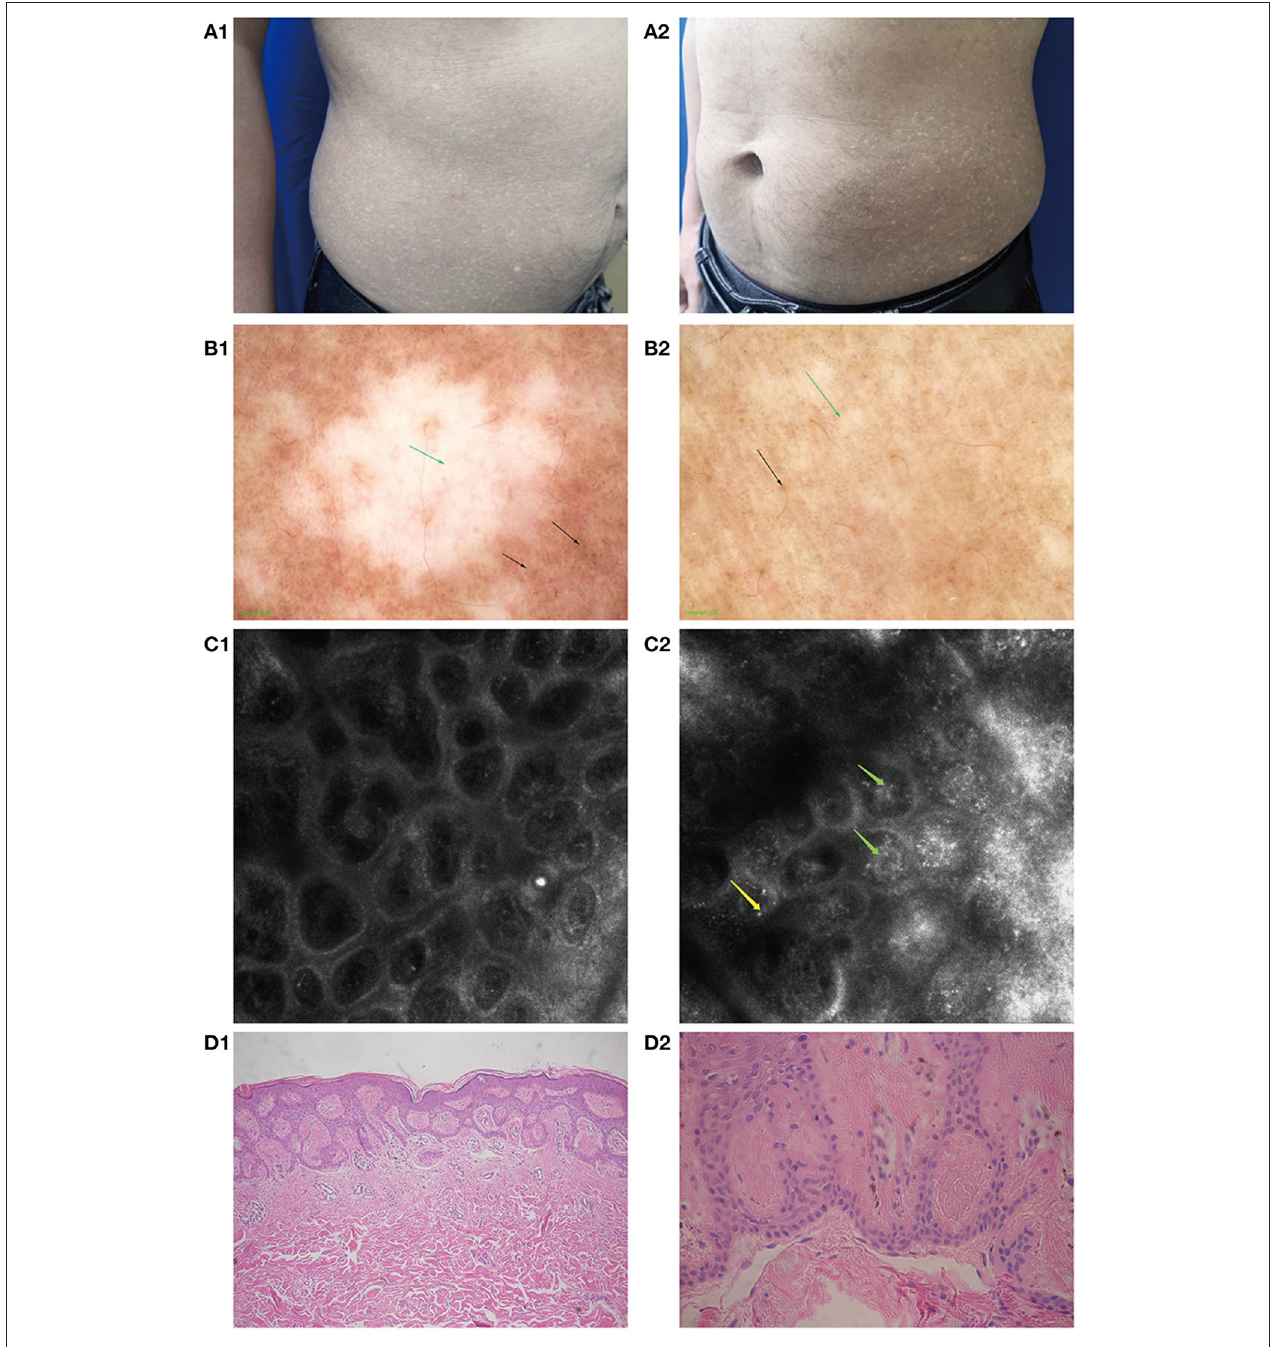
FIGURE 1 | Clinical manifestations, imaging changes, and pathological changes in amyloidosis cutis dyschromica (ACD). (A1,A2) Hyperpigmented and hypopigmented macules on the abdomen of a patient with ACD. (B1,B2) Feature of ACD under dermoscopy. (B1) Hypopigmented areas: white patch (green arrow) with blurred margins, white and brown blotches (black arrow) surrounded. (B2) Hyperpigmented areas: large fulvous pigmentation spots (black arrow), interspersed with white grid-like stripes and patches (green arrow). (C1) RCM performance in some normal skin areas: no obvious amorphous deposits. (C2) Feature of ACD under RCM. The highly refractive substance inside the papillary dermis (like clumpy, dotted, and linear structures, green arrow) and highly refractive round cell scattered in the superficial dermis (yellow arrow). (D1) Mildly hyperkeratotic epidermis along with amorphous eosinophilic materials in the papillary dermis (HE, × 100). (D2) Eosinophilic materials stained positive (Congo red, ×